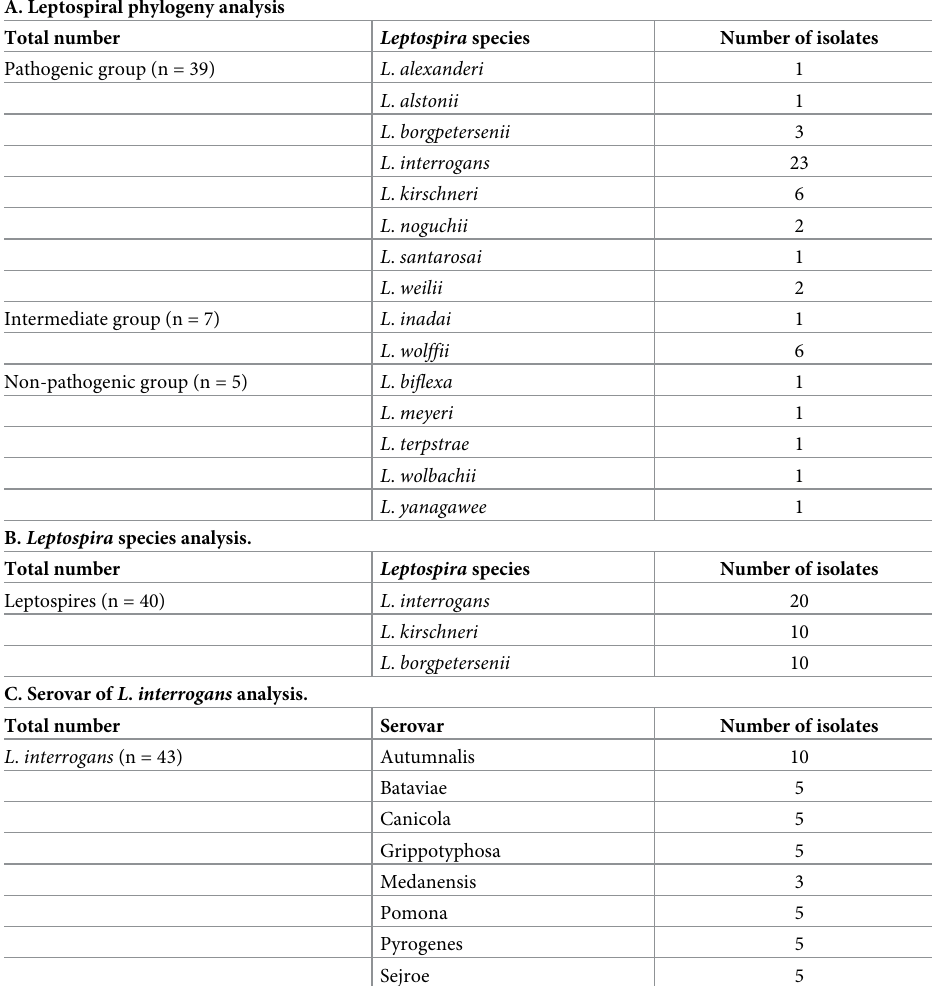
Table 3. List of three MALDI-TOF MS training set for identification of